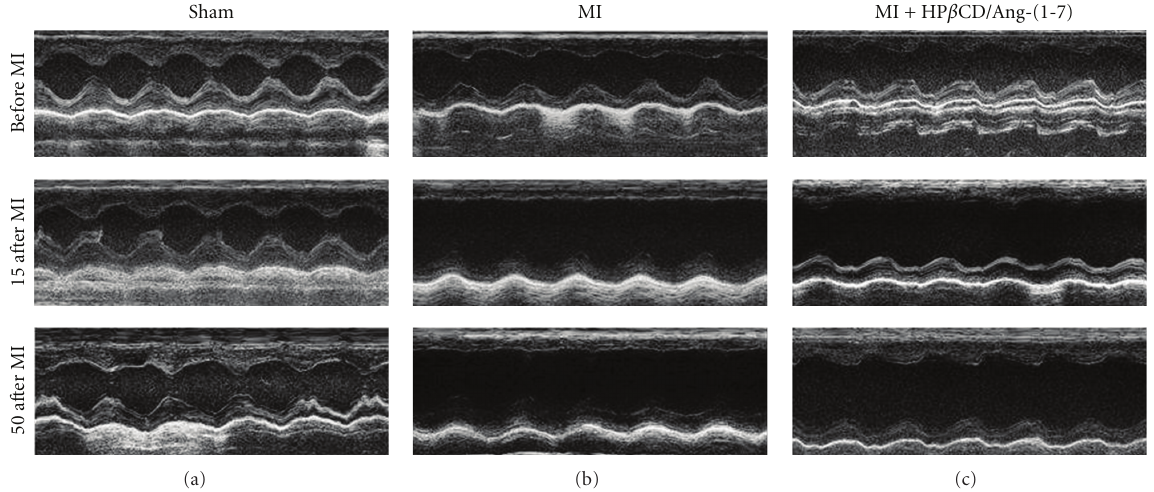
Figure 2: Representative M-mode images showing cardiac function and left ventricle chamber dimensions in sham, MI, and MI + HP β CD/Ang-(1–7)-treated rats. Note the marked increase in end-systolic dimension (ESD) and in end-diastolic dimension (EDD) after infarction and the improvement in the cardiac function after 50 days in rats treated with HP β CD/Ang-(1–7).